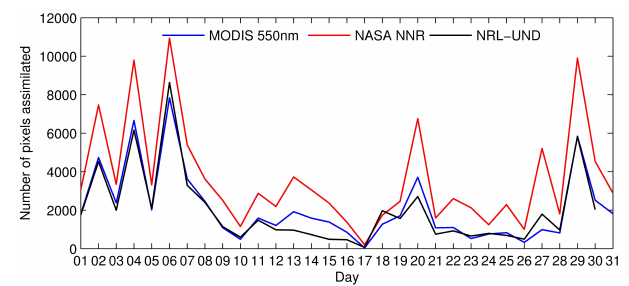
Fig. 9. Time series of the number of pixels being assimilated for each day in May 2010 for the different 550nm AOD data